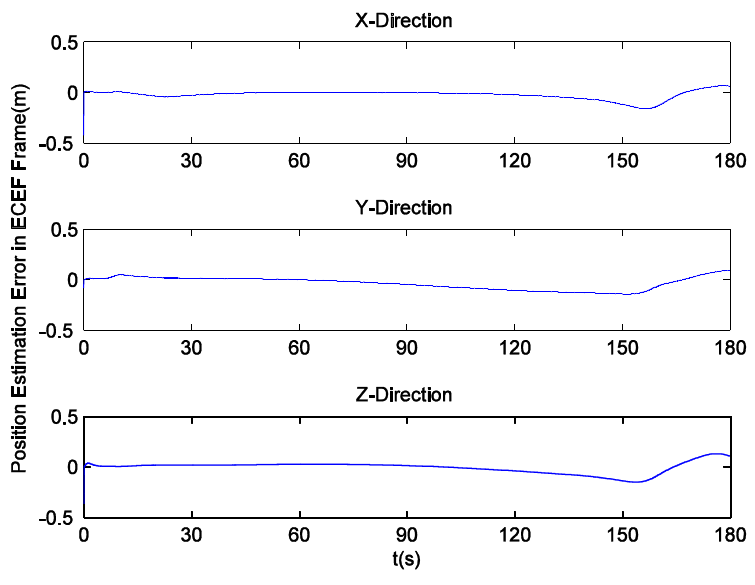
Figure 18. GPS/INS position estimation errors.